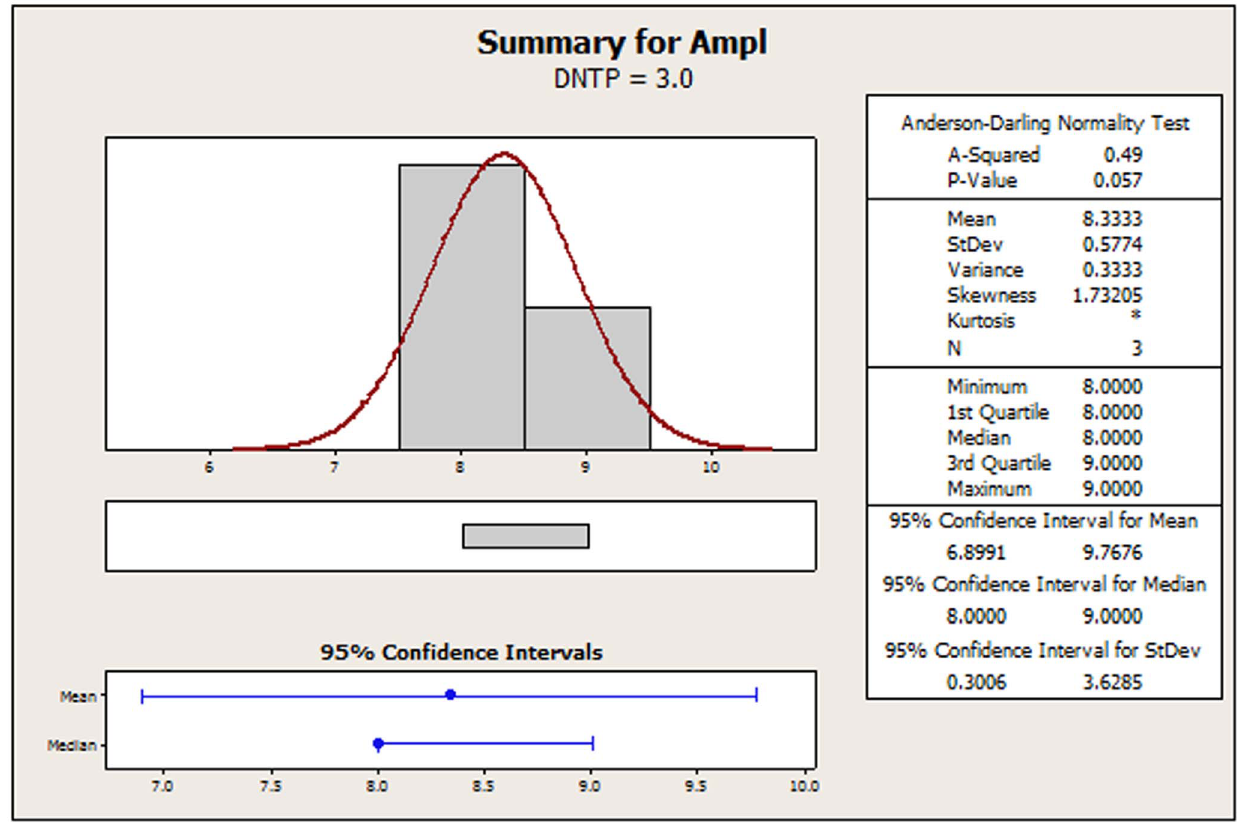
Figure 3. Summary statistics of amplicon performance for DNTP concentration at 3.0 mM.